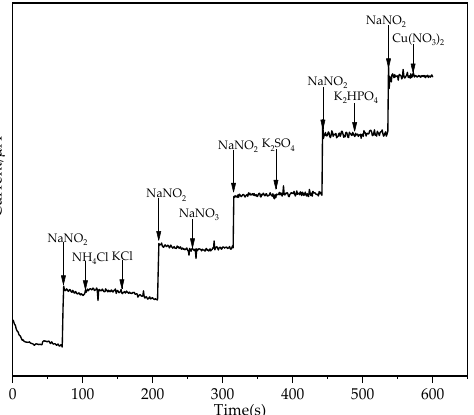
Figure 8. Typical amperometric current responses at AuNPs/MXene/ERGO/GCE for addition of 50